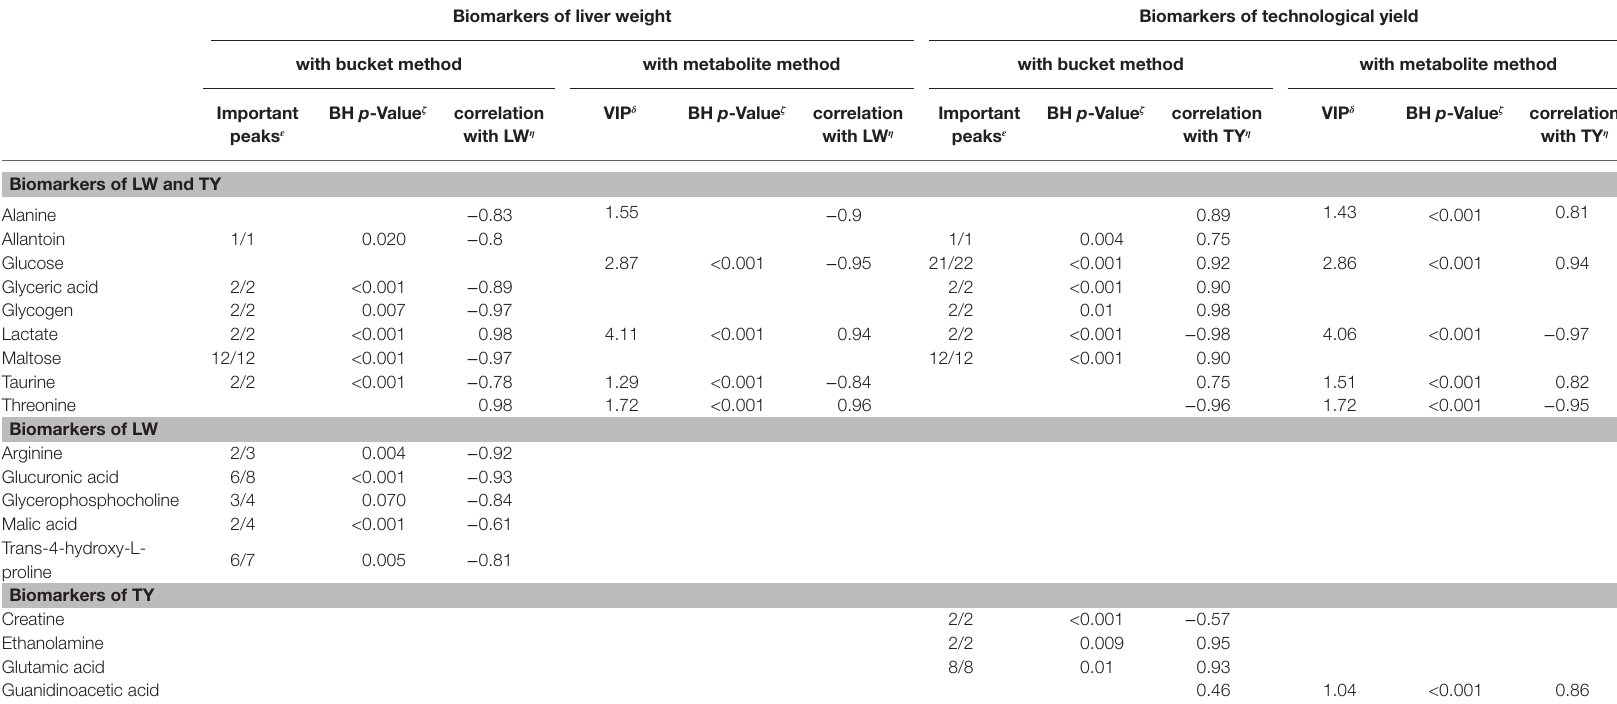
TABLE 5 | List of the biomarkers of liver weight and technological yield of foie gras